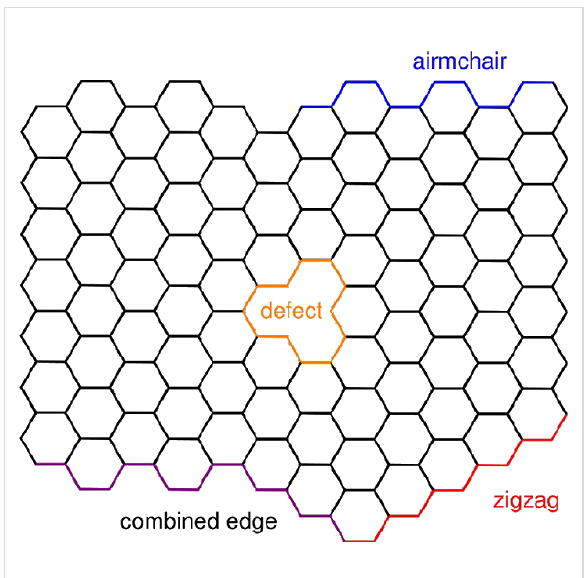
Figure 5: Schematic representation of reactive sites in graphene: surface faces, edges, and defects. Reprinted with permission from [22], copyright 2013 American Chemical Society.